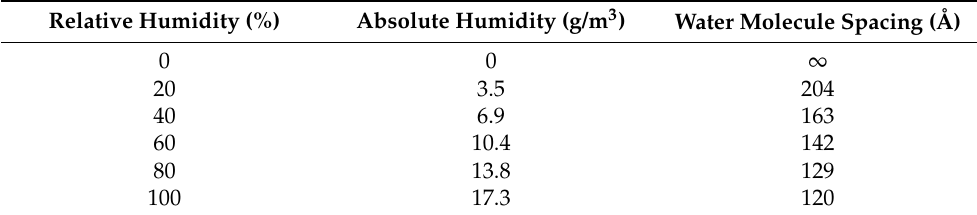
Table 1. The relation between average water molecule spacing and humidity at 20 ◦ C. Relative Humidity (%) Absolute Humidity (g/m 3 ) Water Molecule Spacing